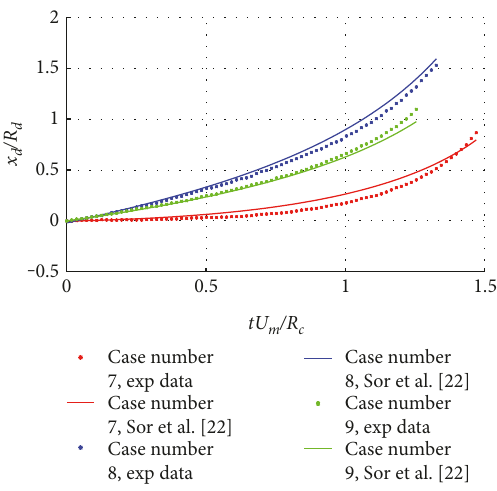
Figure 20: Comparison of the recorded droplet ’ s horizontal position for cases #7, #8, and #9 with those obtained by integrating the theoretical model presented by Sor et al. [22].